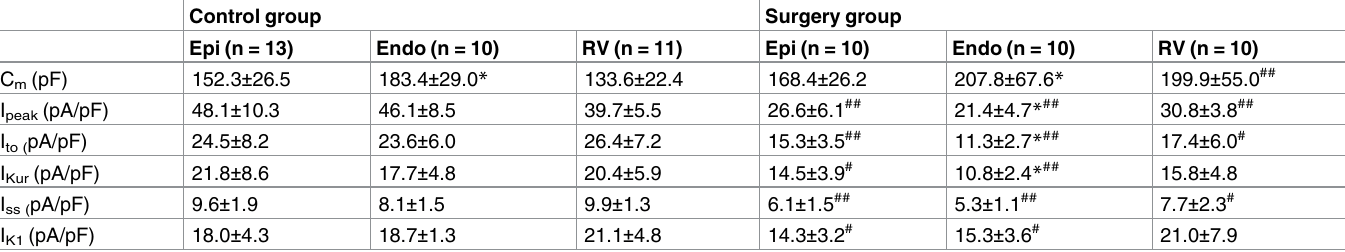
Table 3. Peak densities of K + currents in myocytesof epicardium, endocardium and the right ventricle. Control